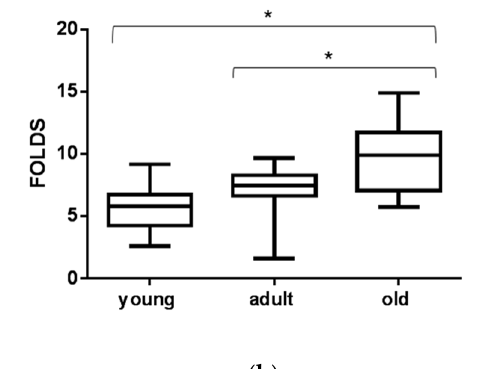
Figure 2. MiR-126-3p levels in sEVs of CTRs are modulated by aging. Scatterplots showing relative miR-126-3p expression according to age in CTRs ( a ). Box and Whiskers indicate median, minimum and maximum levels of miR-126-3p in sEVs from plasma of healthy CTRs divided in age class (24–44 years, n = 20), adult (53–68 years, n = 20) and old (81–96 years, n = 20) ( b ). CTs (cycle thresholds) resulting from qRT-PCR analysis were normalized with mir-30a; levels were calculated with 2- ∆ CT method and expressed as folds, with respect to lowest value registered. Comparison among multiple groups was analyzed by one-way analysis of variance, followed by Bonferroni’s post hoc test. * p <